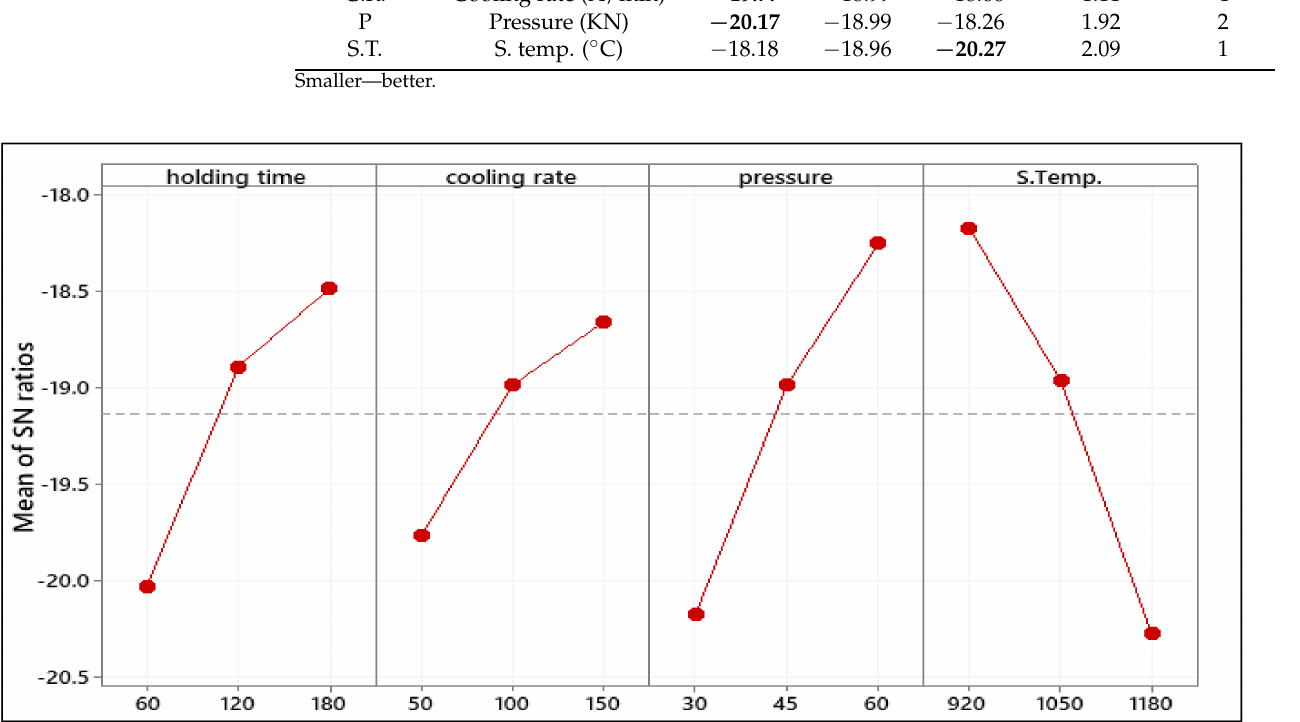
Figure 6. Mean S/N ratio of Mr ⊥